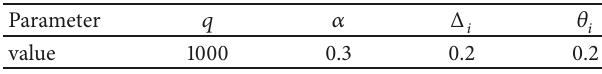
Table 2: Parameters of basic scene.